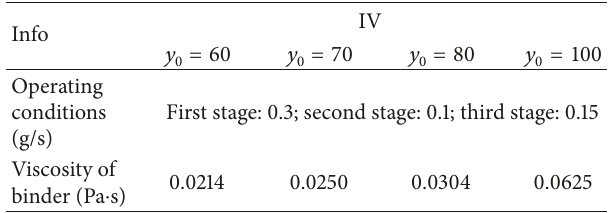
Table 1: The detailed establishing information of representative IVs. Info